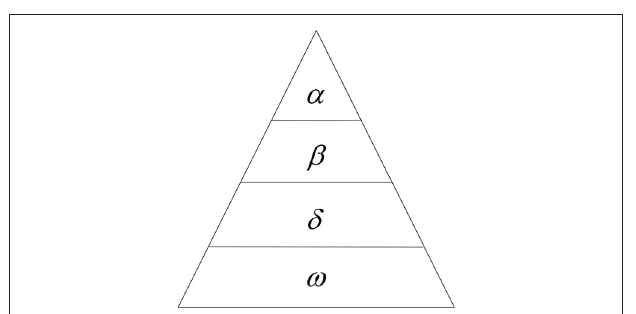
FIGURE 2 | Grey wolf social